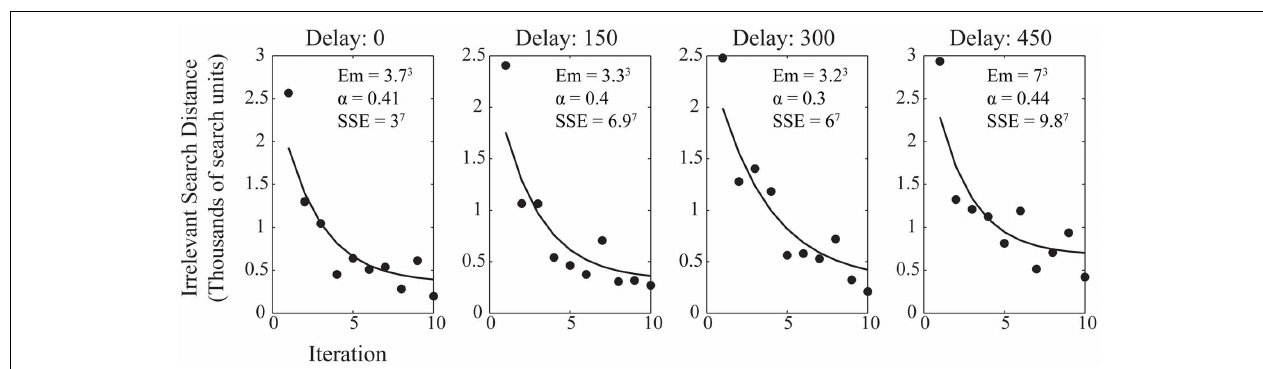
FIGURE 4 | Average participant performance across the 10 iterations for each delay condition. Data shows the fitted power law curve which describes the rate of improvement in performance well. Annotations show